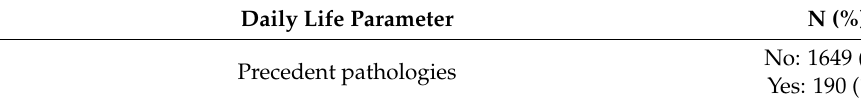
Table 2. Descriptive statistics of daily life parameters. Daily Life Parameter N